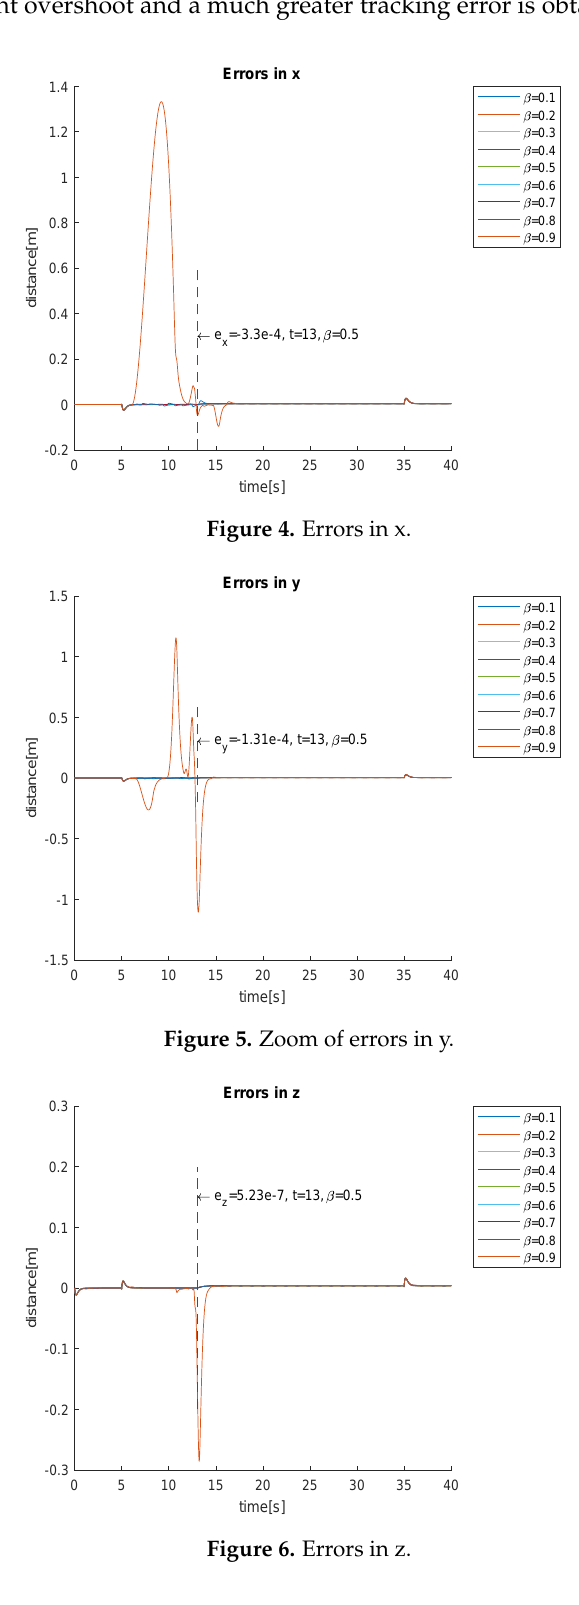
Figure 6. Errors in